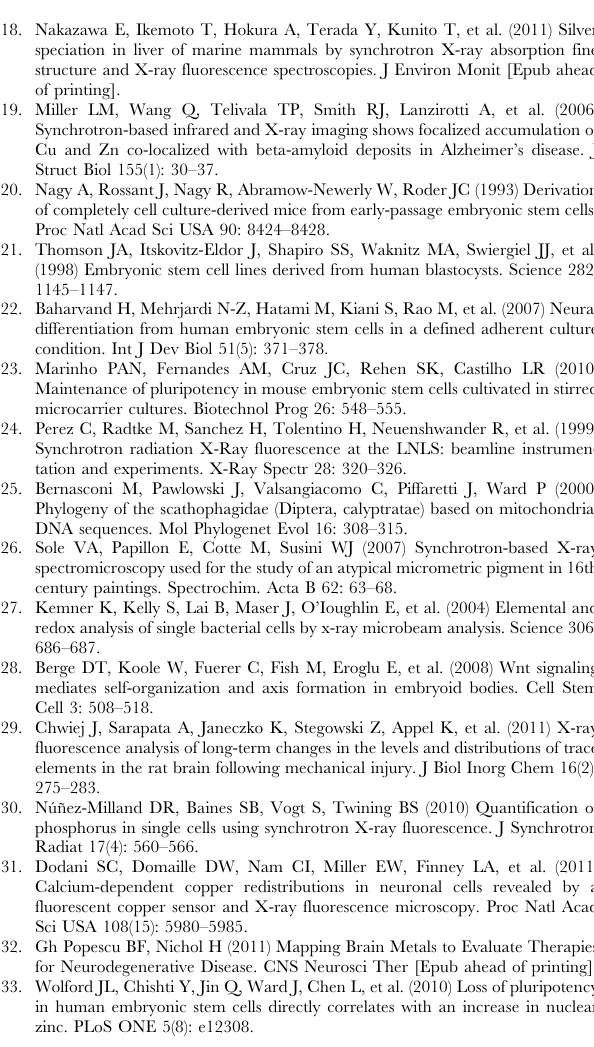
Figure S3 Embryoid bodies do not present morpholog- ical differences in their original spherical shape. Bright field images of human embryoid bodies in suspension culture. A) 7 days old; B) 14 days old control non-induced; C) 14 days old neural induced. Scale bar 100 m m for all images. Figure S4 Dark areas do not correlate with elemental distribution. A line) 7 days old human EB without dark areas. B line) Example of other 7 days old human EB that possess a dark area that does not correlate with elemental distribution. Figure S5 Murine induced pluripotent stem cells-de- rived embryoid bodies present similar elemental distri- bution as mouse embryonic stem cells. A) Elemental maps; B to E) Measure of elemental content normalized per irradiated area for P, S, Cu and Zn, respectively; F) Symmetry measure: